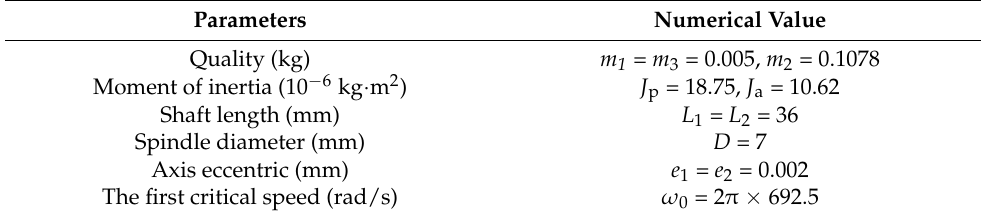
Table 2. Parameters of floating ring bearing.